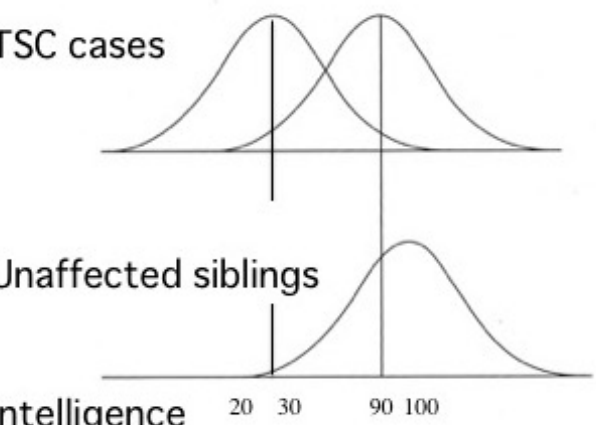
Figure 3. Cognitive function of patients with TSC showing bimodal distribution of IQ (modified from Joinson et al. (2003) [50]). Severe early-onset epilepsy is common in patients with profound ID (IQ < 30), but not in those with normal/subnormal intelligence (IQ around 90). TSC is a common cause of symptomatic ASD, second only to fragile X syndrome in prevalence. The sex ratio (male:female) of entire ASD is 4:1, whereas that of TSC-associ- ated ASD is 1:1 [53,54]. In TSC, ASD is more common in patients with early-onset epilepsy [35,55].